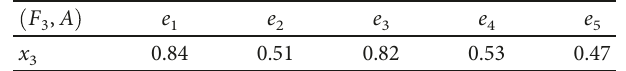
Table 9: Fuzzy soft set F